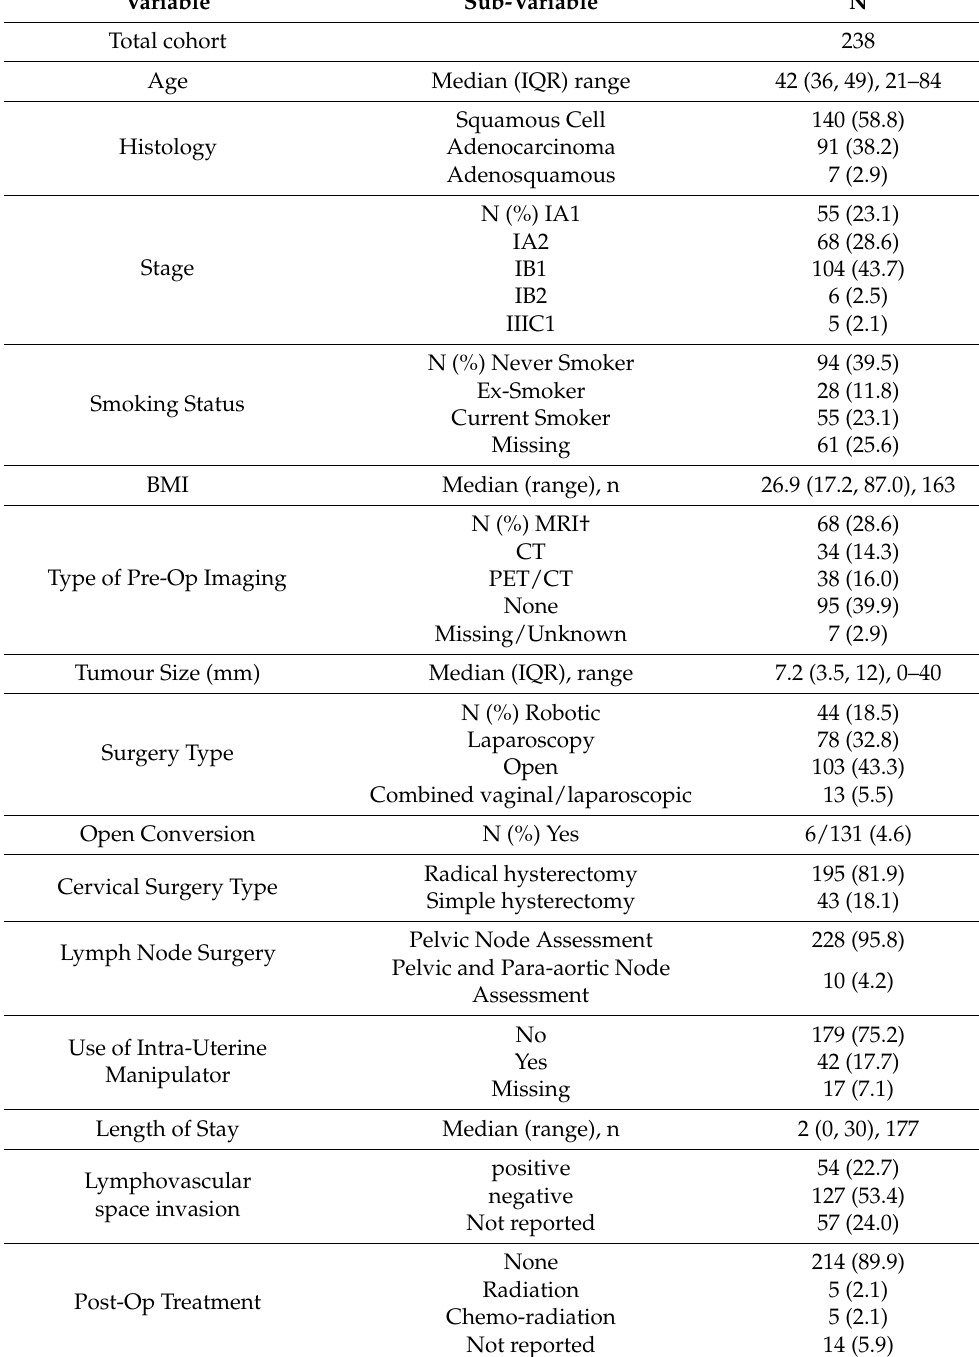
Table 1. Baseline demographic